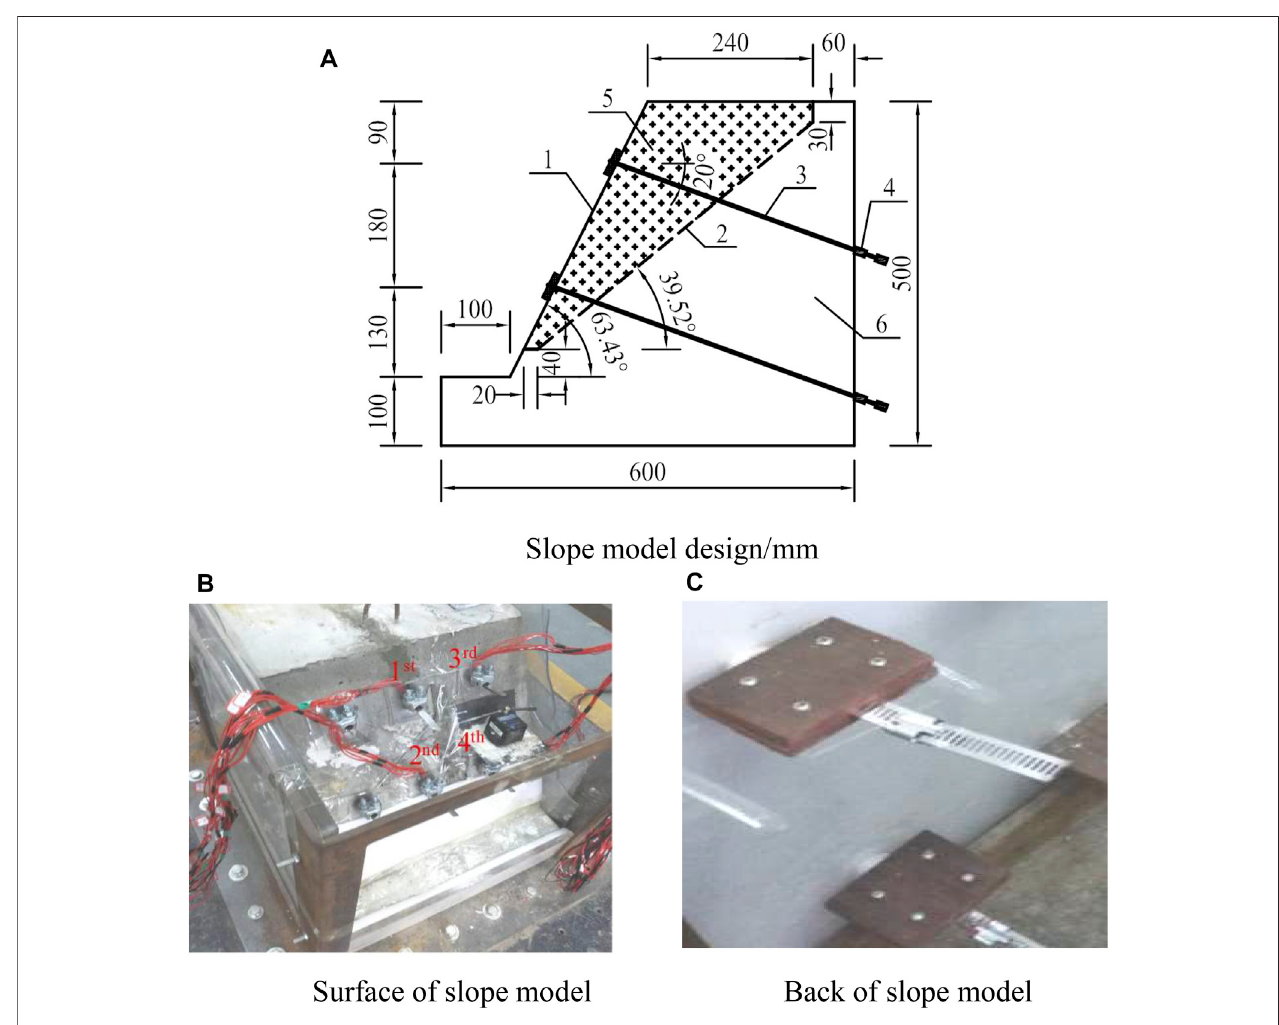
FIGURE8 | Experimental model ofthe anchored slope. 1-slope surface; 2-sliding interface; 3-anchor cable; 4-anti-seismic anchor; 5-sliding block;6-bedrock. (A) Slope model design/mm. (B) Surface of slope model. (C) Back of slope model.